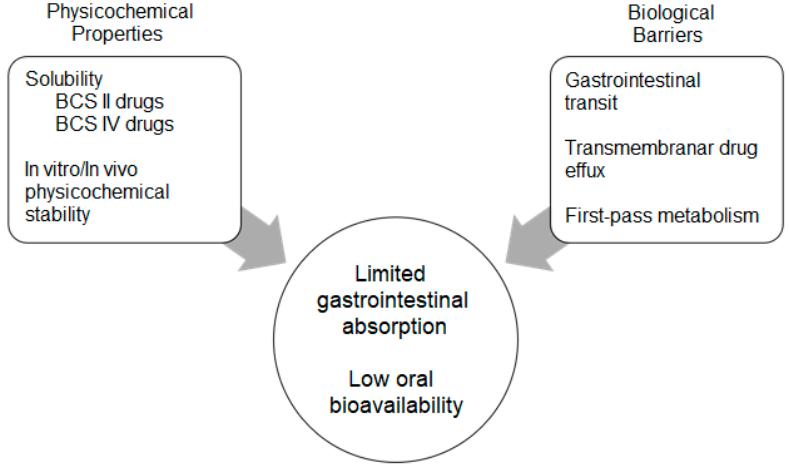
Figure 1. Challenges encountered in oral drug delivery.